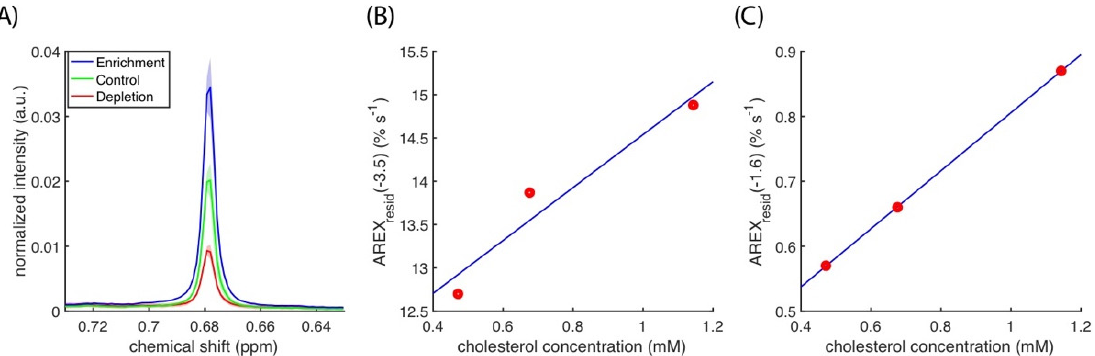
Figure 7. ( A ) Averaged 1 H NMR signal (N = 3) of cholesterol methyl at 0.68 ppm from cholesterol- depleted (red), control (green), and cholesterol-enriched (blue) cell homogenates, in which standard deviations are indicated by shaded areas. Scattering plot illustrating the association between choles- terol concentration and AUCs of AREX resid ( − 3.5) ( B ) and AREX resid ( − 1.6) ( C ), in which regression is indicated by a blue